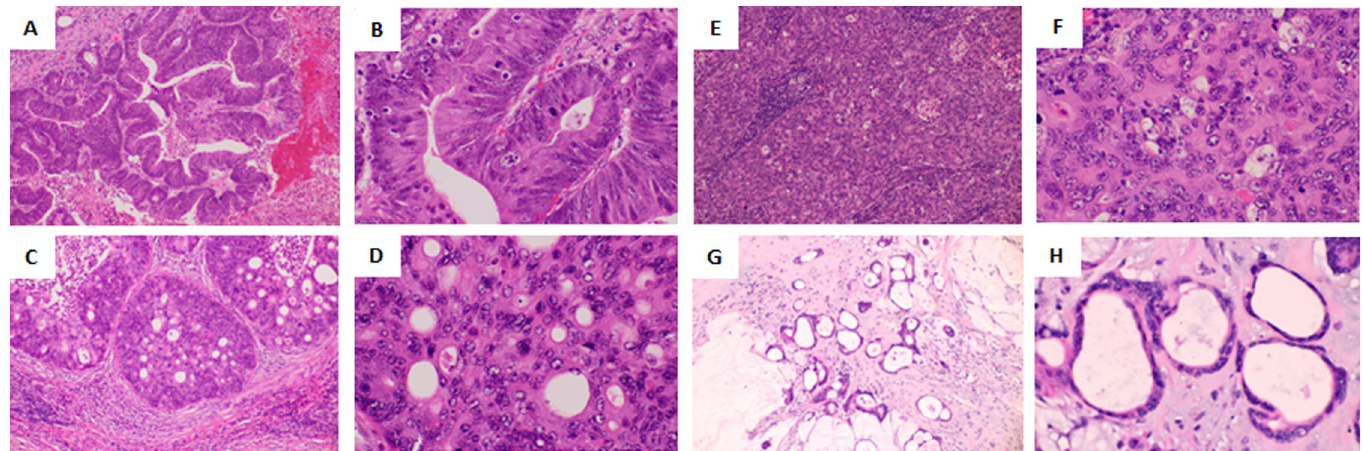
Fig 1. Cancer histology in metastatic lymph nodes. (A,B) Tubular. (C,D) Cribriform. (E,F) Poorly differentiated. (G,H) Mucinous. Original magnification: A, C, E, G: 100 × ; B, D, F, H: 400 × . Staining: Hematoxylin and eosin.